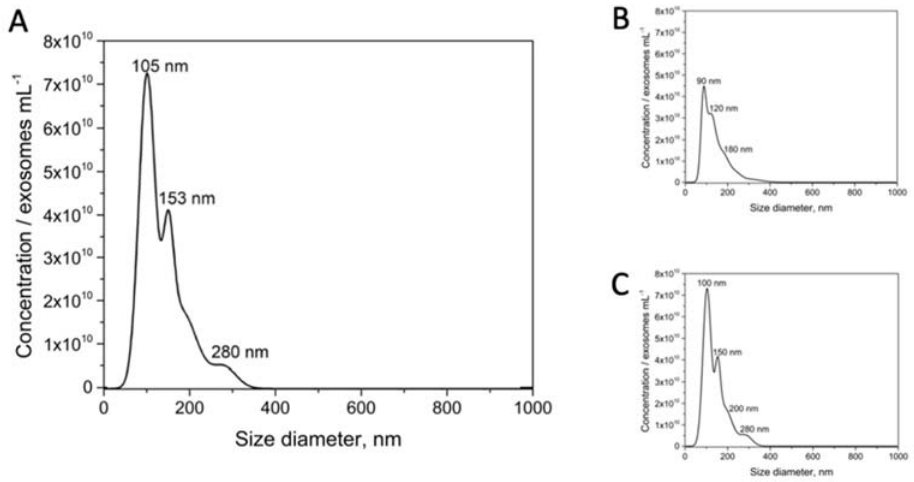
Figure 4. Nanoparticle tracking analysis (NTA) on size distribution on purified exosomes derived from ( A ) MCF7, ( B ) MDA ‐ MB ‐ 231 and ( C ) SKBr3 breast cancer cell lines. The purified exosomes were diluted in sterile ‐ filtered 10 mmol L − 1 PBS buffer (pH 7.5). Nanosight NTA Software analyzed raw data videos